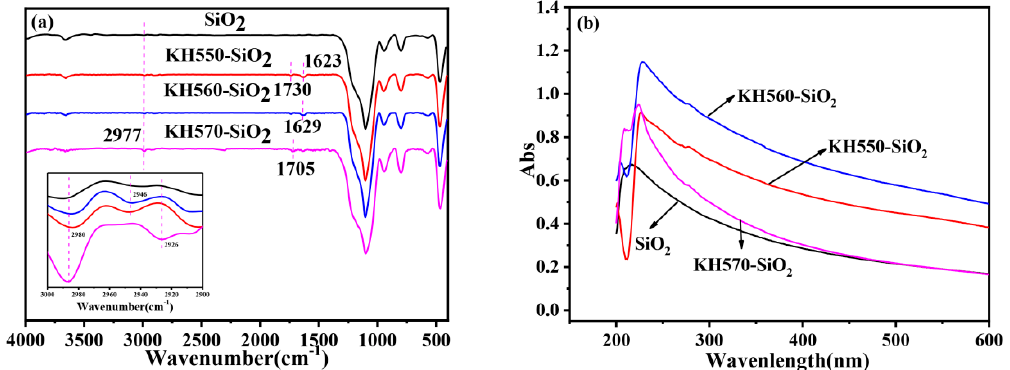
Figure 7. ( a ) FT-IR spectrum of SiO 2 and modified-SiO 2 , ( b ) UV curve of SiO 2 and modified-SiO 2 .